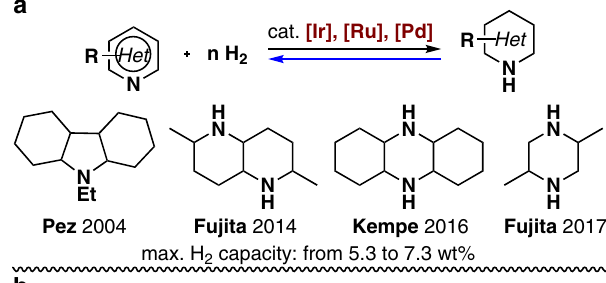
(Table 1, entry 6). N -methyl- N -[2-(methylamino)ethyl]for-